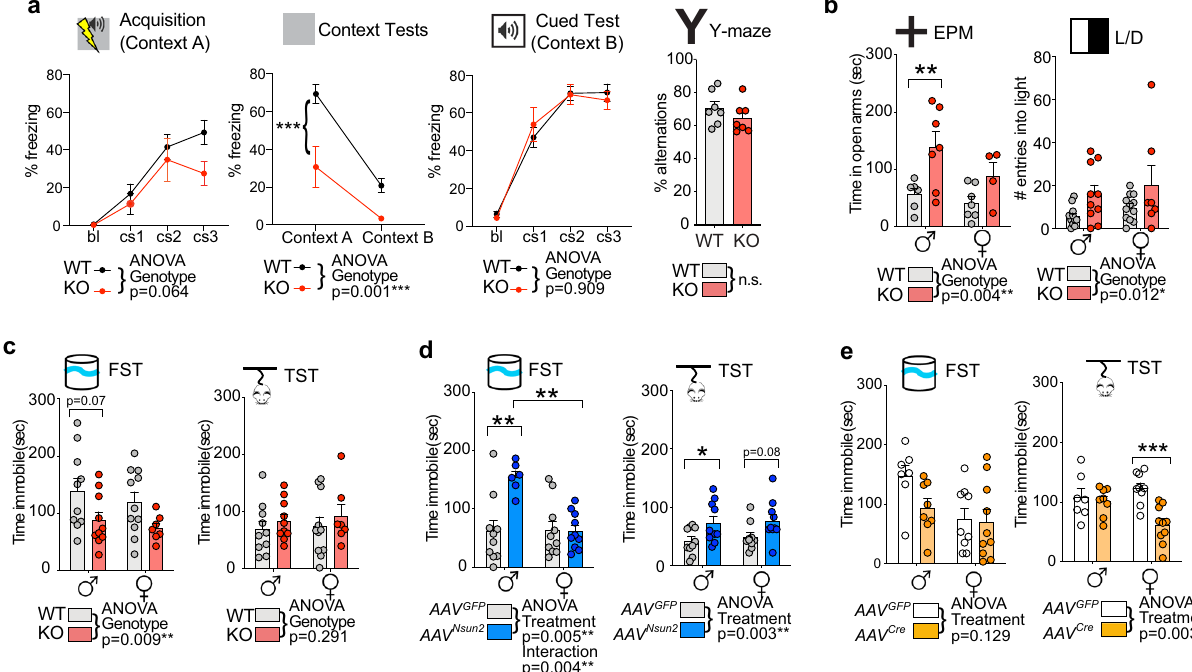
Fig. 5 Manipulation of neuronal Nsun2 modulates complex behaviors, including cognition and depressive behaviors. a Behavioral tests of cognition in adult Nsun2 KO and WT mice ( n = 12 WT, 7 KO). Left, changes in contextual but not cued fear memory in Nsun2 KO mice compared to WT. Right, no changes in working memory were detected in Y-maze spontaneous alternation ( n = 7/genotype; *** P < 0.0001). b Nsun2 KO and WT mice in elevated plus maze (EPM; n = 6 WT M, 7 WT F, 7 KO M, 4 KO F) and light/dark box (L/D; n = 11 WT M, 12 WT F, 10 KO M, 7 KO F; ** P = 0.010 for KO vs. WT males post hoc comparisons). c Nsun2 KO vs. WT mice immobility scores in the forced swim (FST; n = 10 WT M, 11 WT F, 10 KO M, 7 KO F) and tail suspension (TST; n = 10 WT M, 11 WT F, 10 KO M, 7 KO F). d AAV8 hSyn1-Nsun2 GFP vs. AAV8 hSyn1- GFP control mice immobility scores in the FST ( n = 10 AAV GFP M, 10 AAV GFP F, 6 AAV Nsun2 M, 10 AAV Nsun2 F; ** P = 0.002 for post hoc comparisons) and TST ( n = 10/sex/condition; * P = 0.044 for post hoc comparisons). e AAV8 hSyn1-Cre GFP vs. AAV8 hSyn1- GFP control mice immobility scores in the FST and TST ( n = 7 AAV GFP M, 9 AAV GFP F, 8 AAV Cre M, 10 AAV Cre F; *** P < 0 . 001). All data are presented as mean values + / − SEM, and all post hoc t tests are two-tailed with Bonferroni correction. Source data are available as a Source Data fi